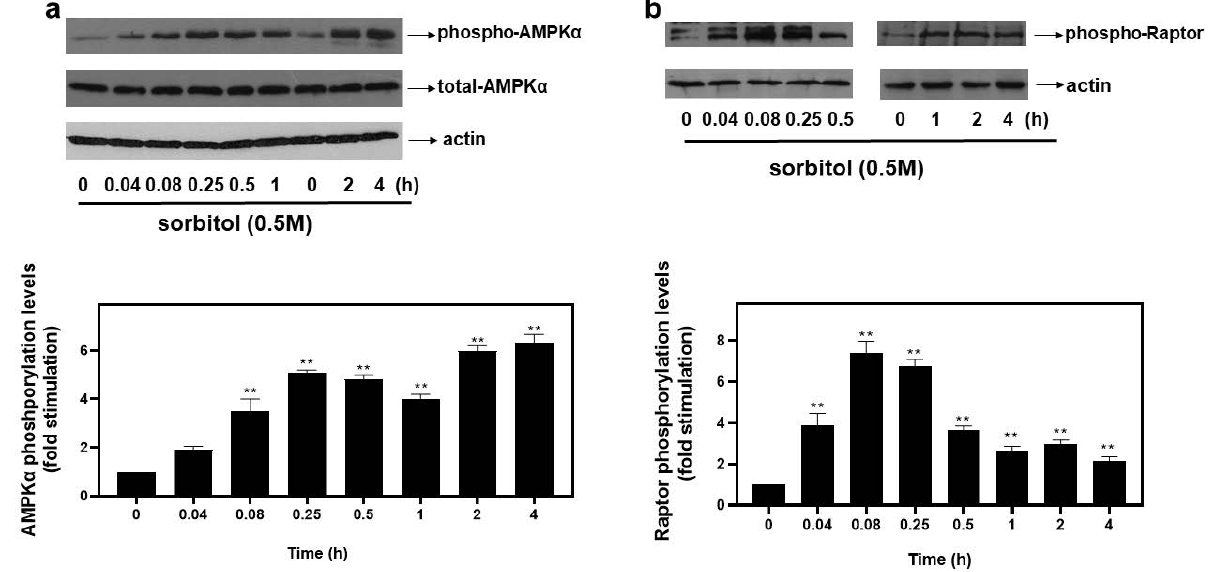
Figure 3. Hyperosmotic stress induces phosphorylation of the alpha catalytic subunit of AMPK (AMPK α ) and Raptor in H9c2 cardiac cells. H9c2 cells were exposed to 0.5 M sorbitol for the times indicated. Protein extracts (40 µ g/lane) were subjected to SDS-PAGE and immunoblotted with antibodies for phosphorylated AMPK α ( a upper panel), total levels of AMPK α (( a ) middle panel), phosphorylated Raptor (( b ) upper panel) and actin (( a , b ) bottom panels). Western blots presented are representative of at least three independent experiments with overlapping results. Immunoreactive bands were quantified by scanning densitometry and plotted (( a , b ) respective graphs). Results are means ± SEM for at least three independent experiments. ** p < 0.01 compared to control